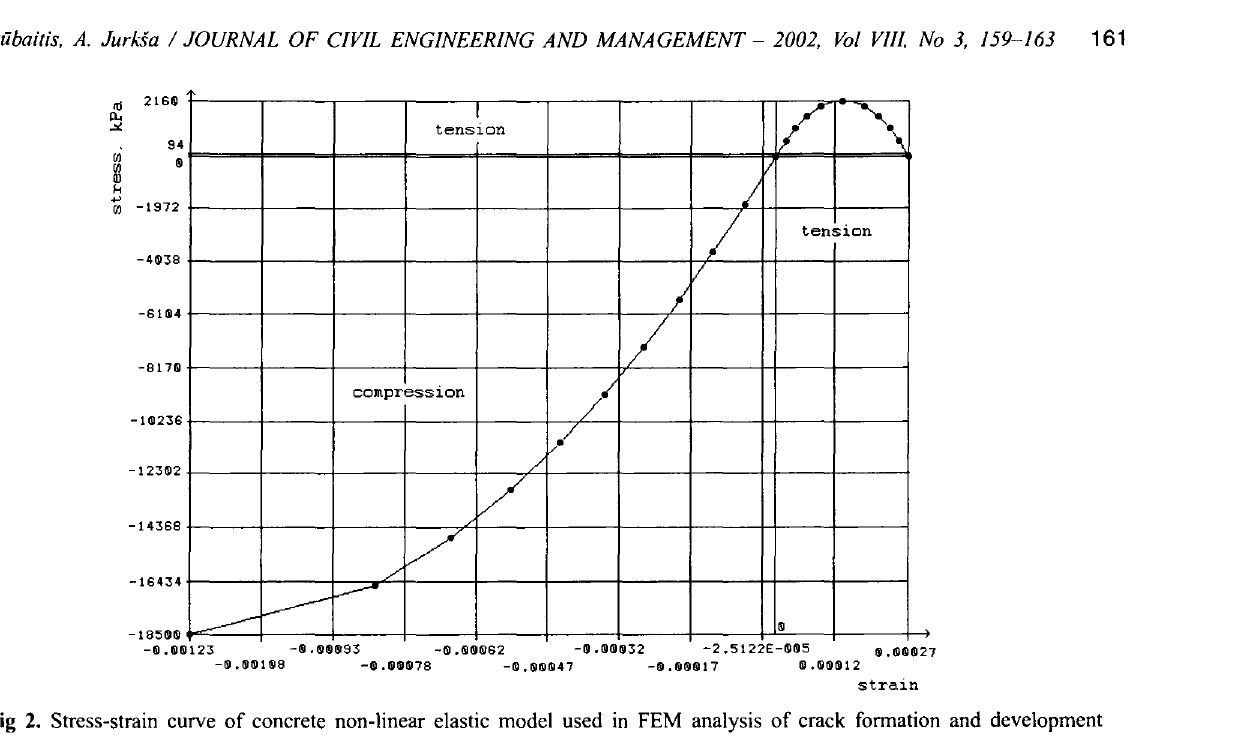
Fig 2. Stress-strain curve of concrete non-linear elastic model used in FEM analysis of crack formation and development The total strain £ vector is used to compute the effective strain Eef